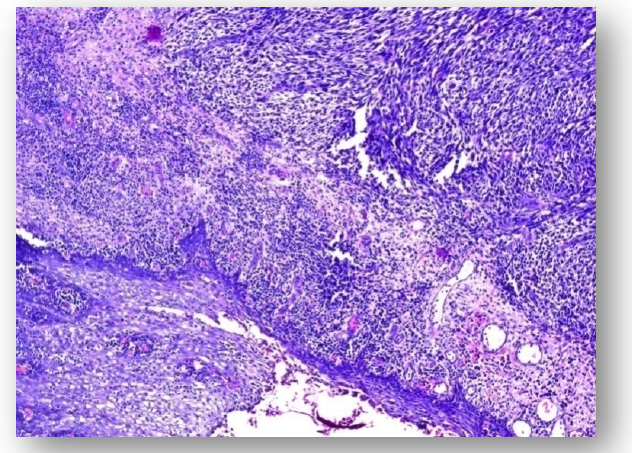
Figure 1. The squamous cell epithelium (in the lower left quadrant), mononuclear cell infiltrate in the subepithelial connective tissue and the tumor proliferation, consisted of sheets of spindle cells, H&E stain, and magnification of ×100.